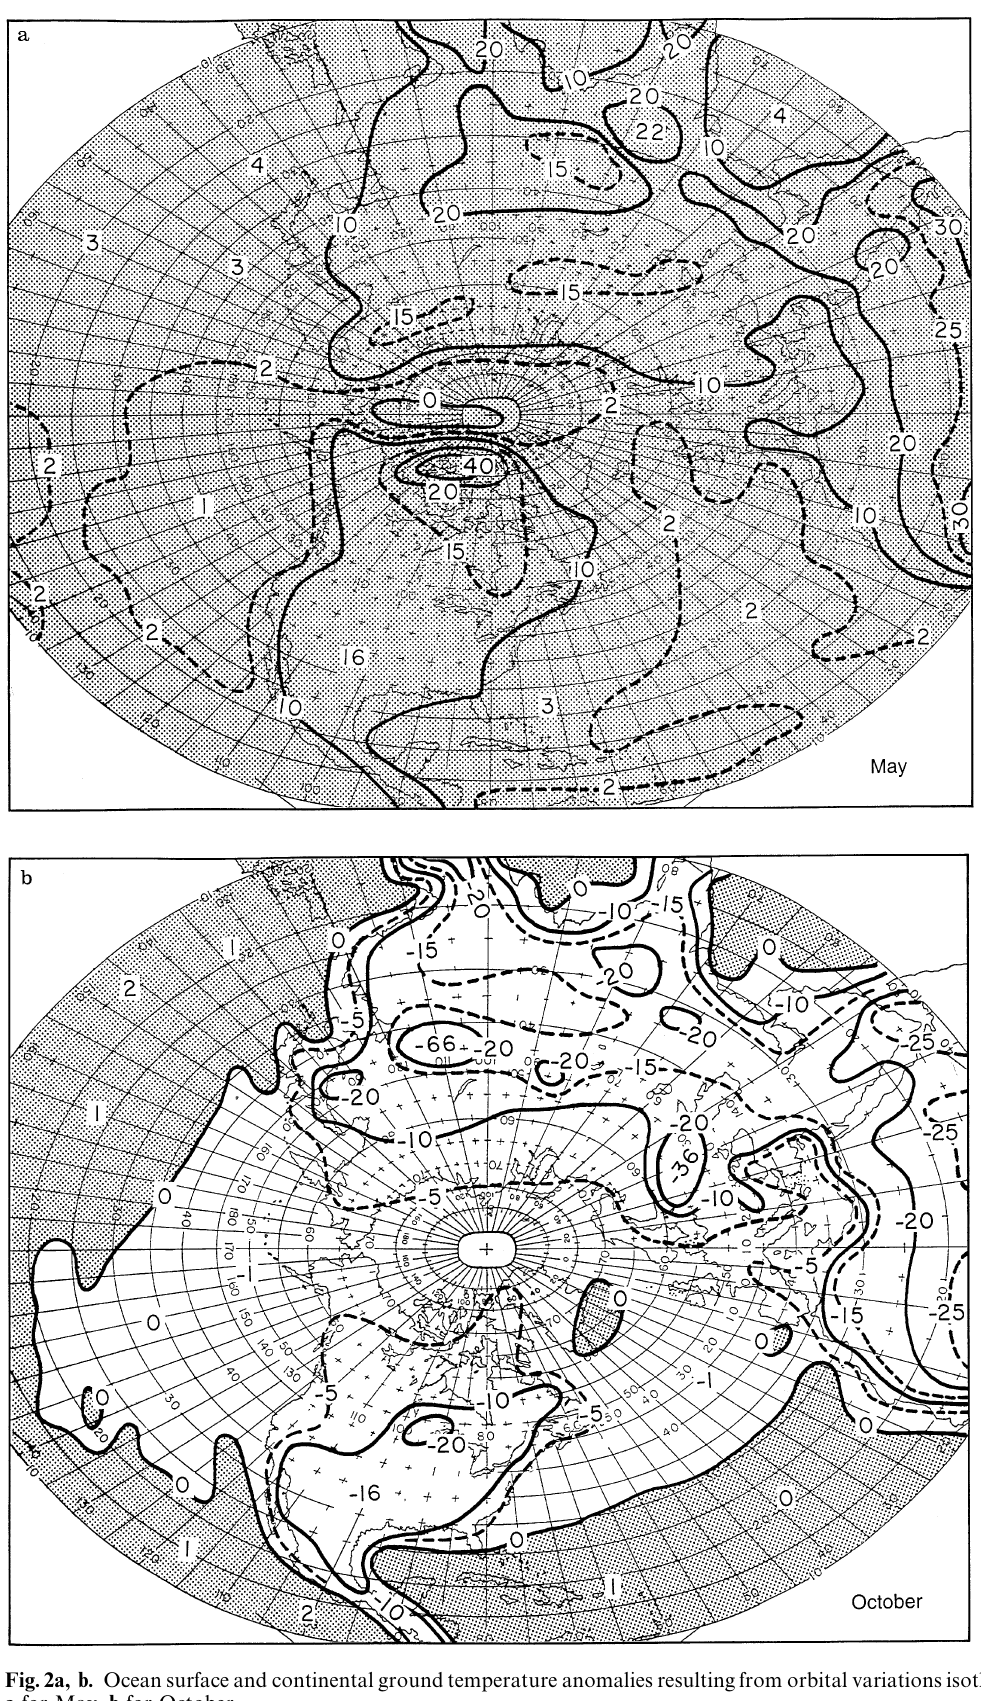
Fig. 2a, b. Ocean surface and continental ground temperature anomalies resultingfrom orbital variations isotherms in 0.1 ° C for 4 kyears AP. a for May, b